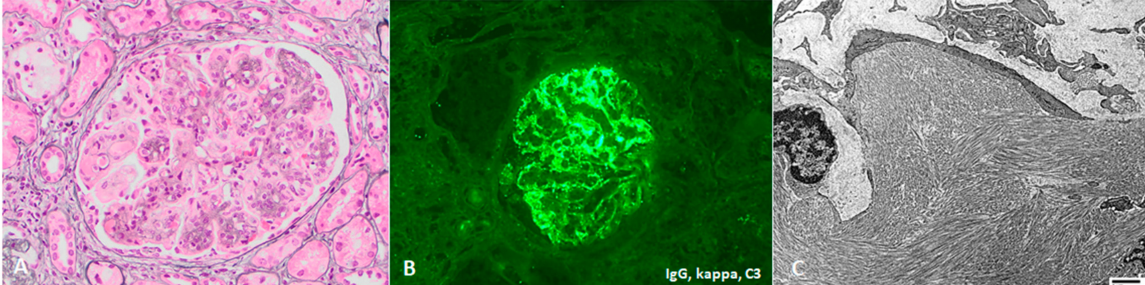
Figure 4. Cryoglobulinemic glomerulonephritis, with ( A ) a membranoproliferative pattern of injury and intracapillary cryoglobulin “plugs” (Jones 200 × ), ( B ) segmentally accentuated mesangial and capillary staining for monotypic IgG and C3 by IF, and ( C ) organized microtubular substructure by EM (direct mag 2900 ×